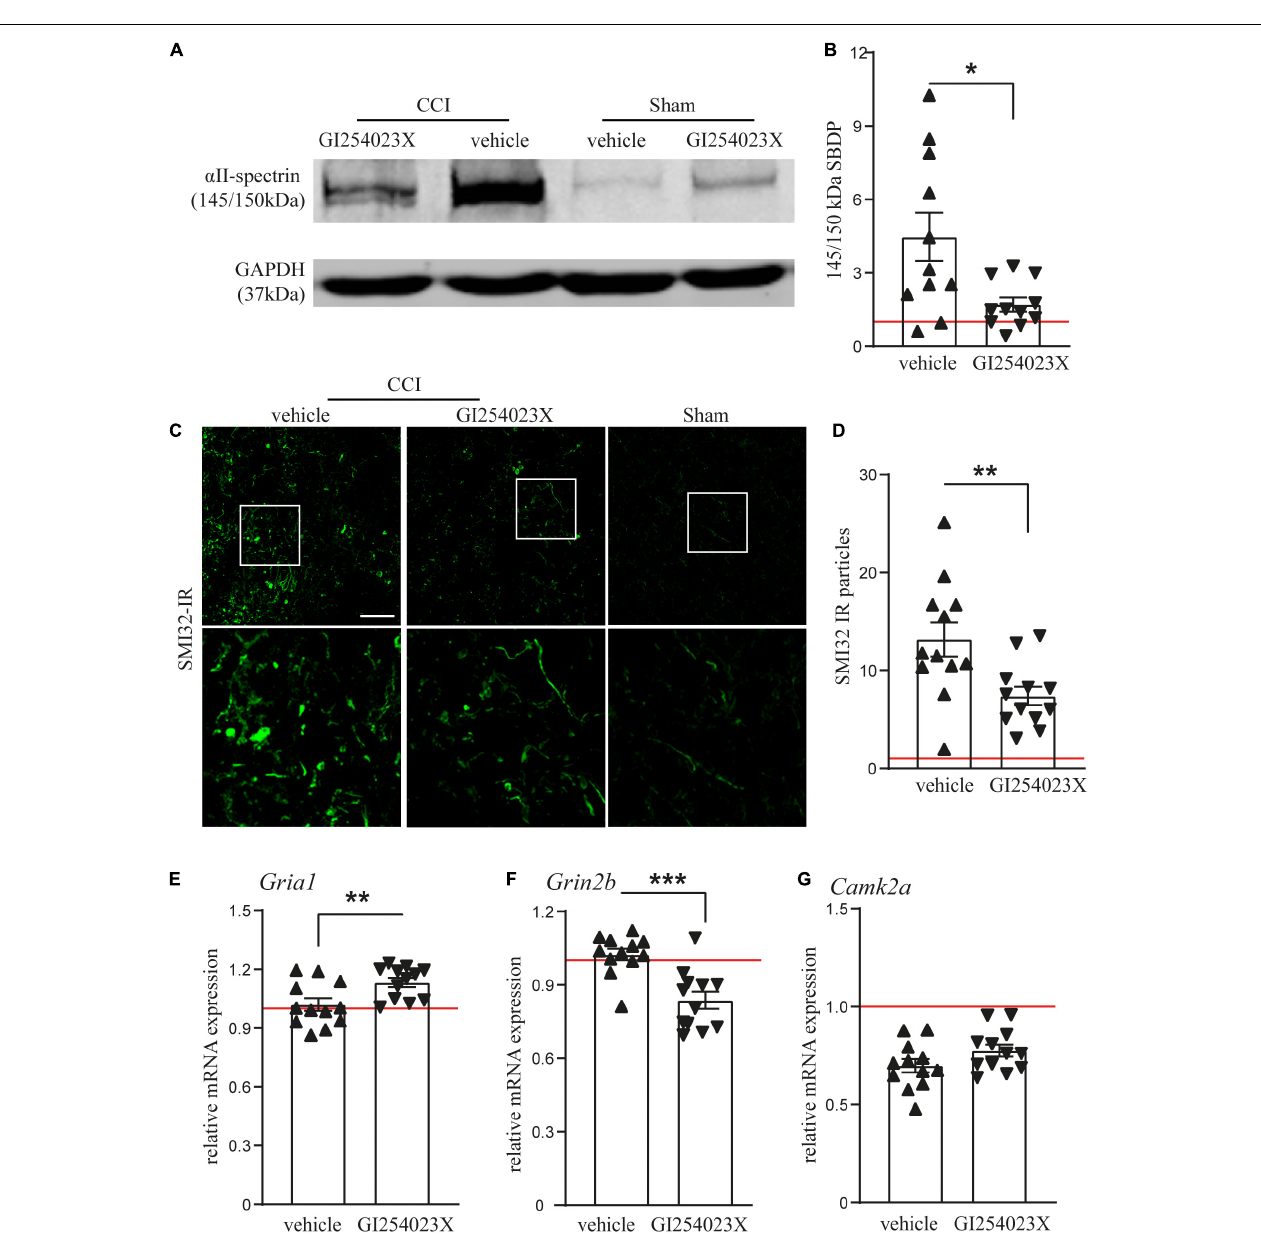
FIGURE 3 | GI254023X reduces axonal injury and alters the gene expression of glutamate receptor subunits after TBI. (A) Representative western blot showing TBI-induced generation of spectrin breakdown products (SBDPs, 145–150 kDa) at 7 dpi in ipsilesional brain tissue samples. (B) Semi-quantitative densitometry of protein bands revealed reduced levels of SBDPs in GI254023X-treated animals compared to vehicle treatment ( n = 11 each). (C) Immunofluorescence images of cryosections for non-phosphorylated Neurofilament-H (SMI-32) at 7 dpi at perilesional sites indicate increased axonal injury at 7 dpi in CCI animals compared to sham. (D) Quantitative assessment of SMI-32 immunoreactive (IR) particles at 7 dpi showing decreased numbers of SMI-32-IR particles in GI254023X- compared to vehicle-treated animals ( n = 12 each). (E–G) Histograms showing relative mRNA expression of AMPAR1 ( Gria1 ), NMDAR2B ( Grin2b), and CamK2A ( Camk2a ) at 7 dpi in ipsilesional brain tissue samples. Expression values were normalized to the reference Ppia (cyclophilin A) and data from CCI animals ( n = 12 each group) are shown relative to sham (red line = sham). Two outliers were removed after identification by ROUT’s test in (B) . Values from individual animals and mean ± SEM are shown. Differences between GI254023X- and vehicle-treated animals were calculated by Student’s t -test (* p < 0.05, ** p < 0.01, *** p < 0.001).